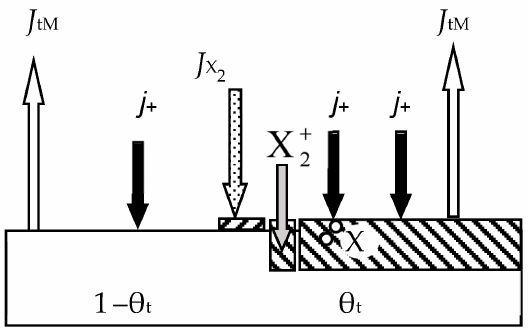
Figure 11. The fl uxes on the target surface. Figure 11. The fluxes on the target